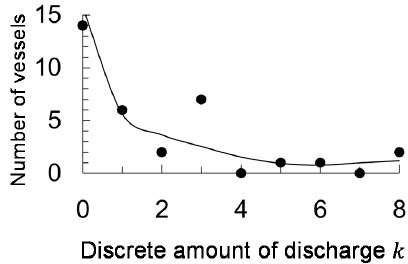
Figure 6. Number of vessels versus amount of discharge. Solid line is from the variable discharge probability model, and closed circles are from observation.